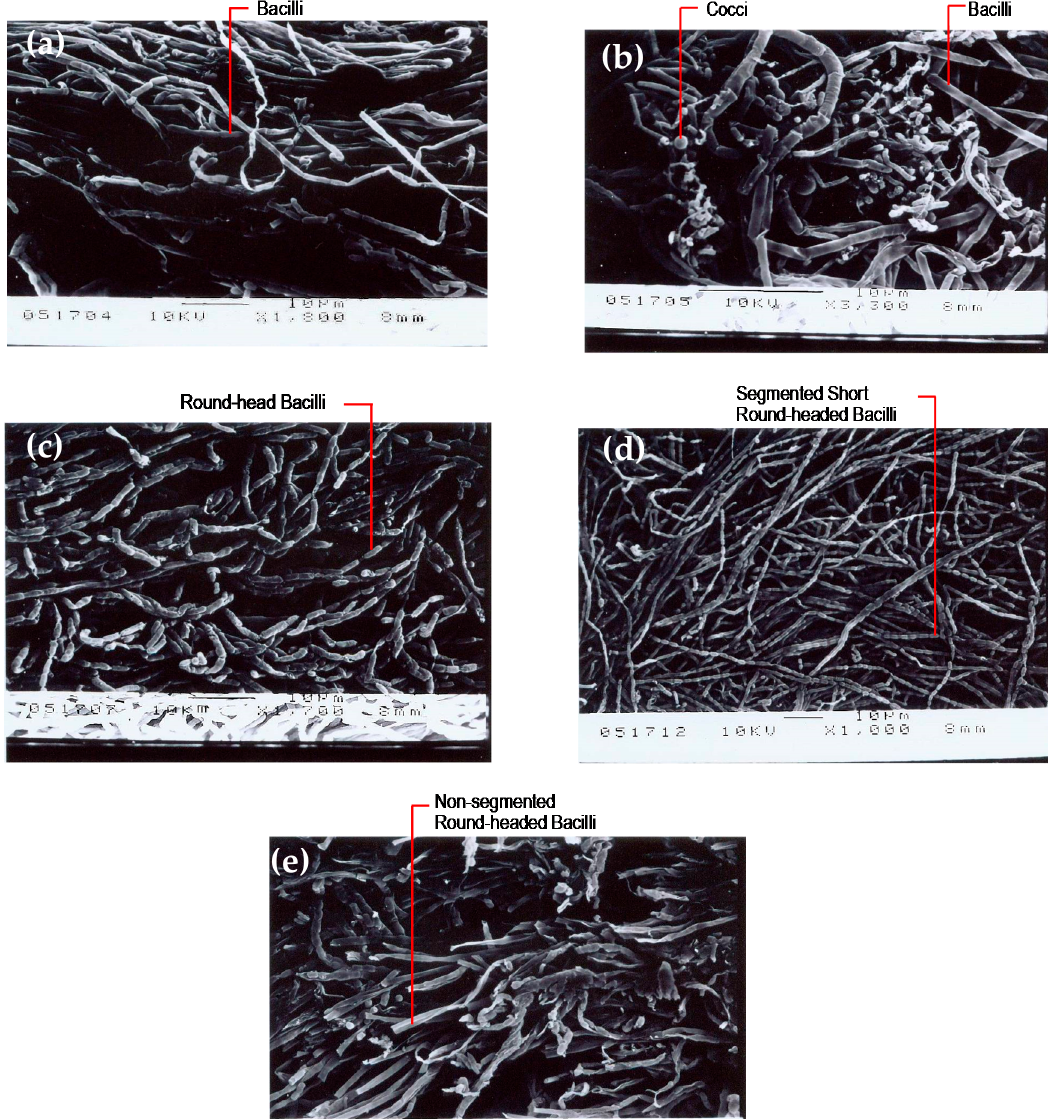
Figure 8. ( a ) Biological phase of first tank in AS system during stable period; ( b ) biological phase of second tank in AS system during stable period; ( c ) biological phase of first tank in AS / CA system during stable period; ( d ) suspended biological phase of second tank in AS / CA system during stable period; ( e ) fixed biological phase of second tank in AS / CA system during stable phase.